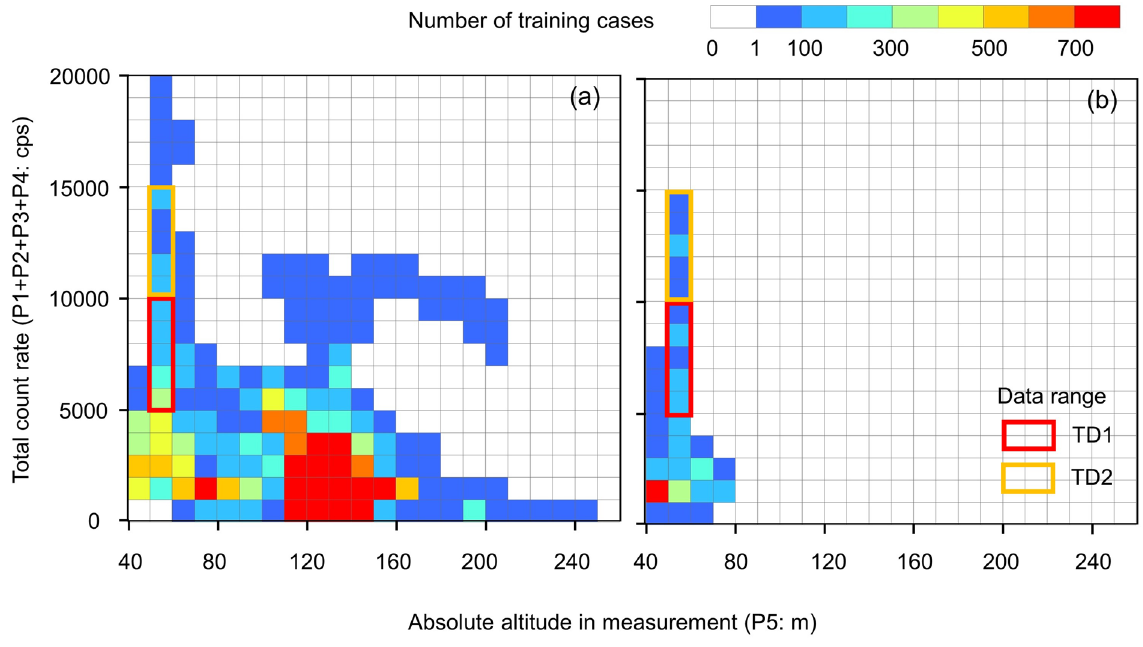
Figure 4. Characteristics of the ( a ) training set (37,936 cases) and the ( b ) test set (3442 cases). The areas of TD1 and TD2 are the training cases presented in Fig.